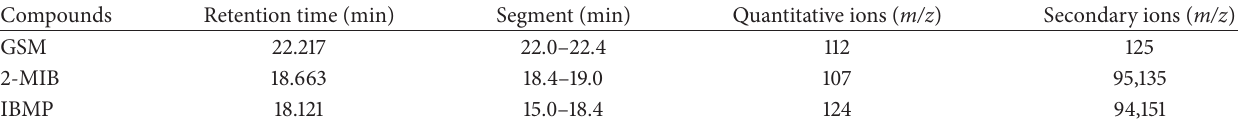
Table 2: The parameters of the MS scan function (SIM mode) for the determination of analytes.